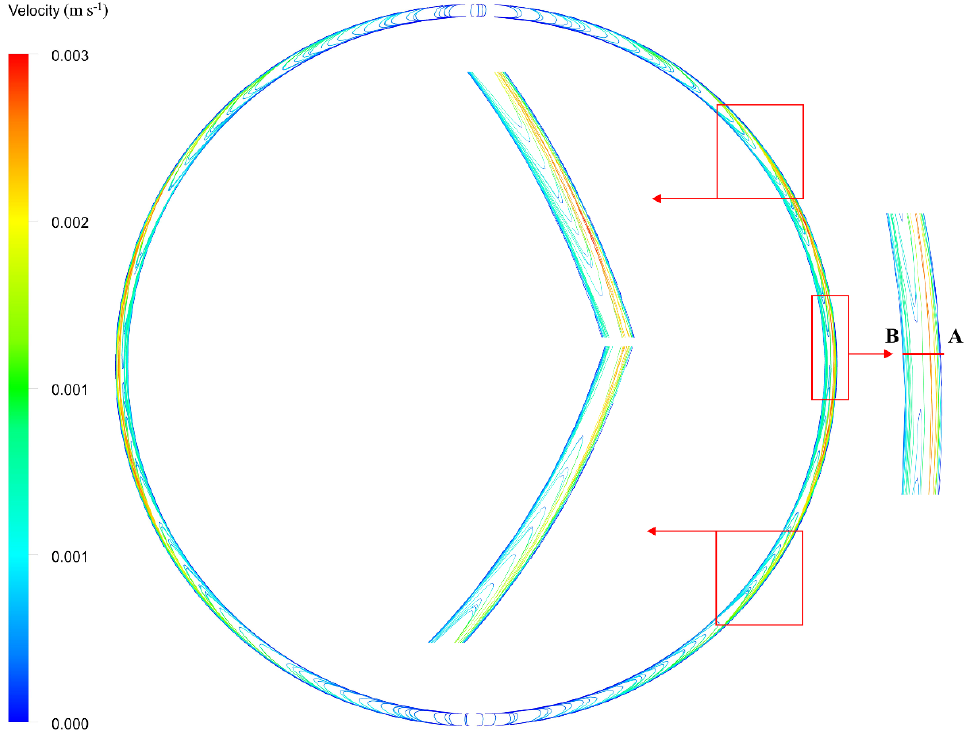
Figure 9. Streamline of Y – Z section in the closed annulus cavity.